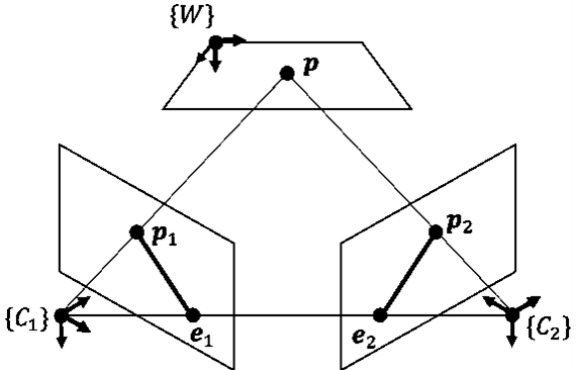
Figure 2. Epipolar